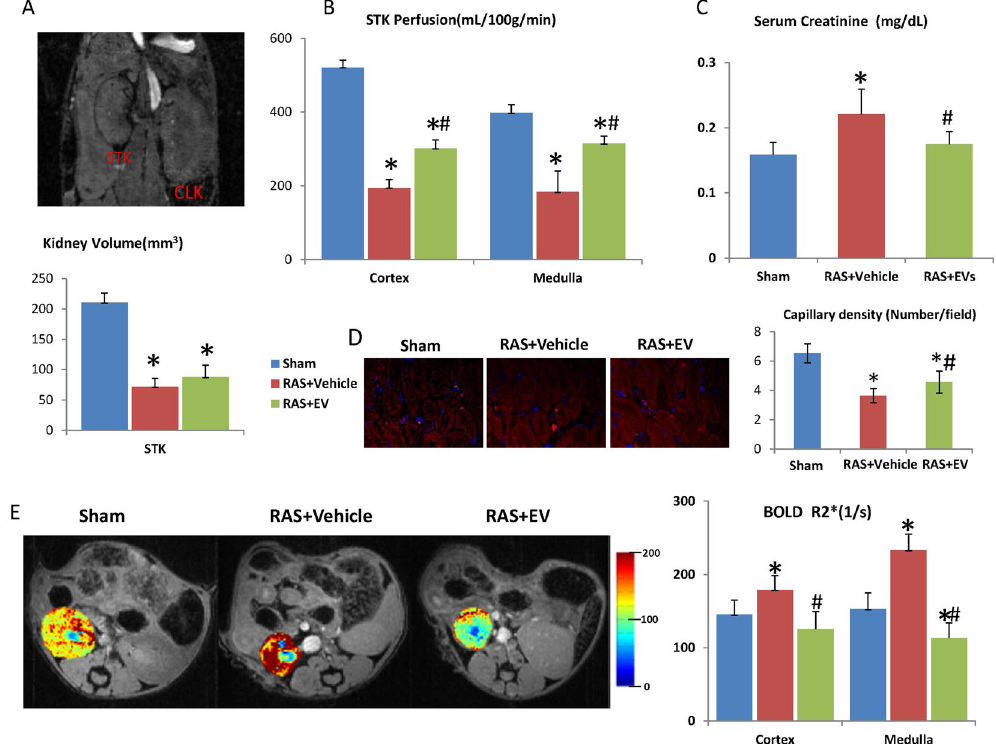
Figure 6. Renal hemodynamics in stenotic kidney (STK) of mice. ( A ) STK volume decreased significantly 4 weeks after RAS compared to Sham, and no significant difference from RAS + EV. ( B ) STK cortical and medullar perfusion showed a significant decrease, which was improved by EV. ( C ) Higher serum creatinine in RAS compared to the Sham 4 weeks after surgery, which was restored by EV. ( D ) Peritubular capillary density was significantly decreased in RAS + Vehicle, but improved after EV treatment. ( E ) Decrease of STK oxygenation was observed in RAS + Vehicle compared to the Sham both in the cortex and medulla, which was restored by EV ( * P < 0.05 vs SHAM, # P < 0.05 vs RAS +